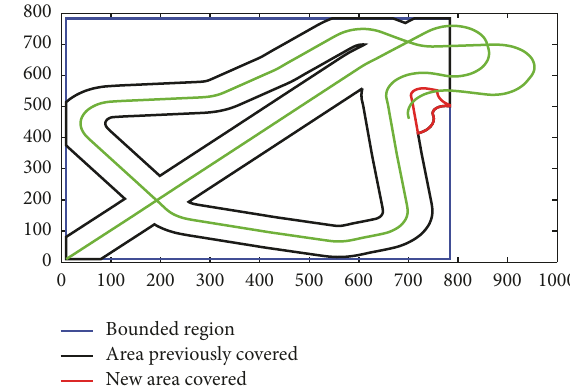
Figure 9: Illustrative example of the area calculation. The contours are defined by a matrix of the vertices. Matlab routines are utilized to compute the area covered based on these